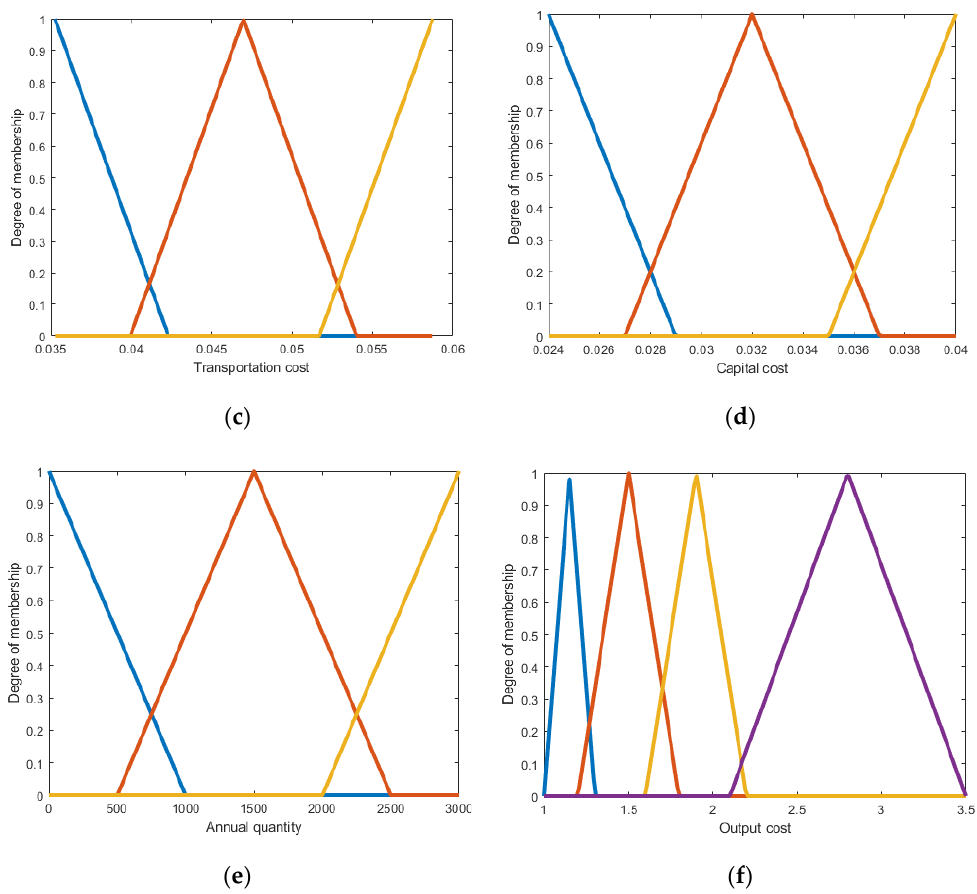
Figure 6. Membership functions of output cost and second-stage fuzzy inputs — ( a ) dismantling cost; ( b ) operational cost; ( c ) transportation cost; ( d ) capital cost; ( e ) annual quantity; ( f ) output cost. Fuzzy sets colour key: blue — low; red — medium; yellow — high; and purple line — very high.